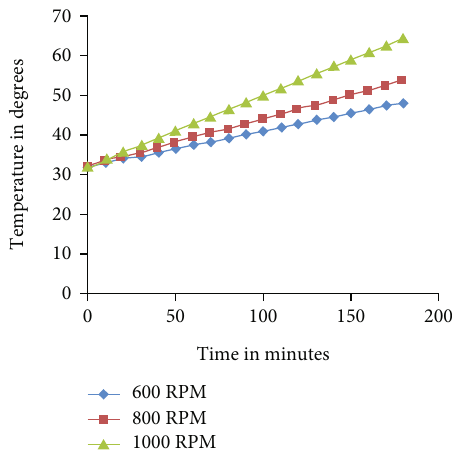
Figure 16: Time – temperature graph of GO-GFN bearing.